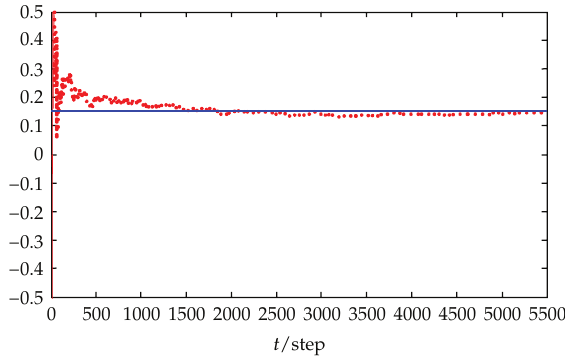
(cid:11) d (cid:5) t (cid:6) 12